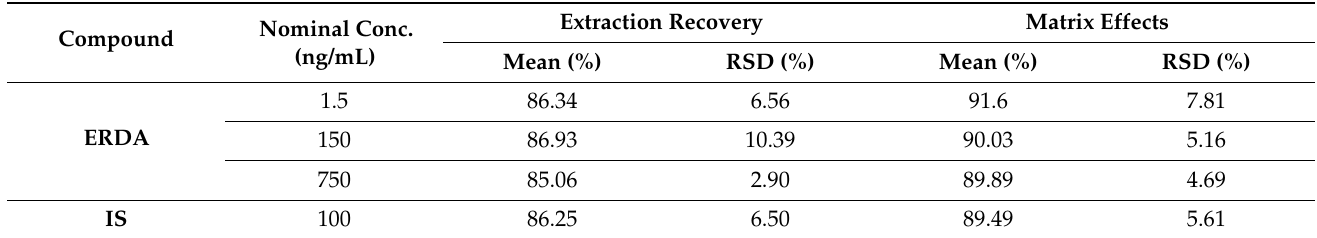
Table 3. Recovery % and matrix effects ERDA and IS in